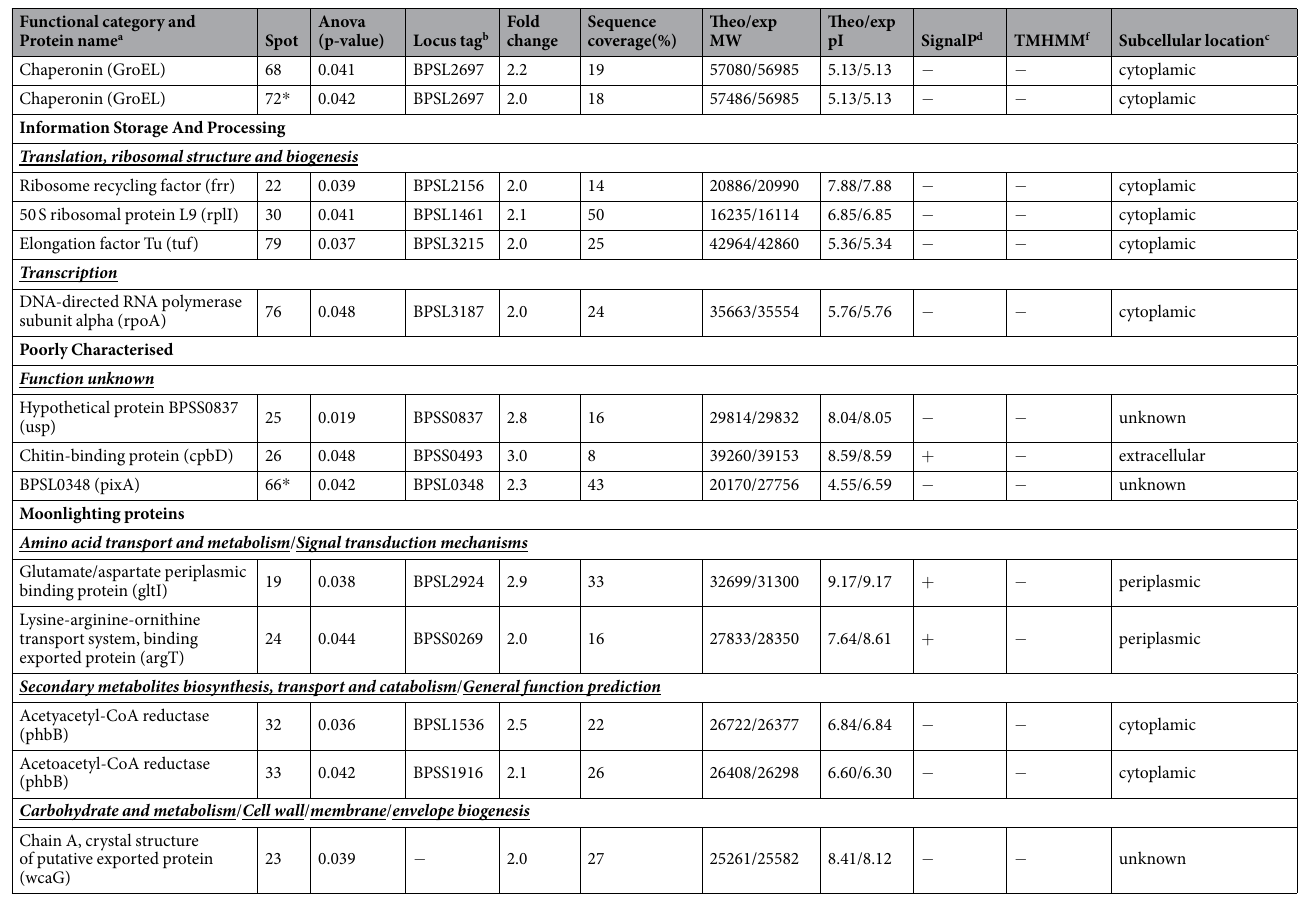
Table 2. Identification of Burkholderia pseudomallei soil isolate, Bp MARAN , up-regulated proteins in National Centre for Biotechnology (NCBI) non-redundant sequence using Mascot search engine data from MALDI- TOF mass spectrometry. * Missing proteins in Bpmouse-adapted. a Functional category based on Clusters of Orthologous Groups (COG) of protein. b Locus tag obtained from Burkholderia Database. c Subcellular location predicted using the PSORT analysis. d Presence of signal peptide predicted by SignalP server v. 3.0. e Number of predicted transmembrane helices in protein using TMHMM server v.